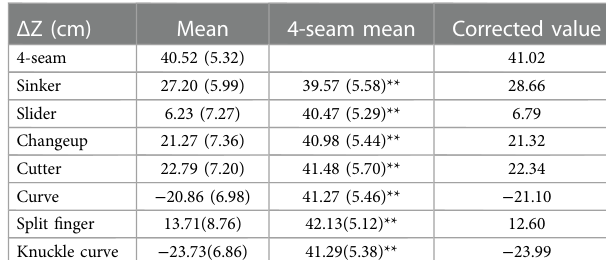
“ 4-seam mean ” indicates the data on 4-seam corresponding to each changing ball type. “ Corrected value ” meansthe value calculated using Formula 3. The difference was determined using the paired t -test between the 4-seam mean corresponding to each changing ball type and corrected values. Data are expressed as mean with standard deviation (SD). ** p